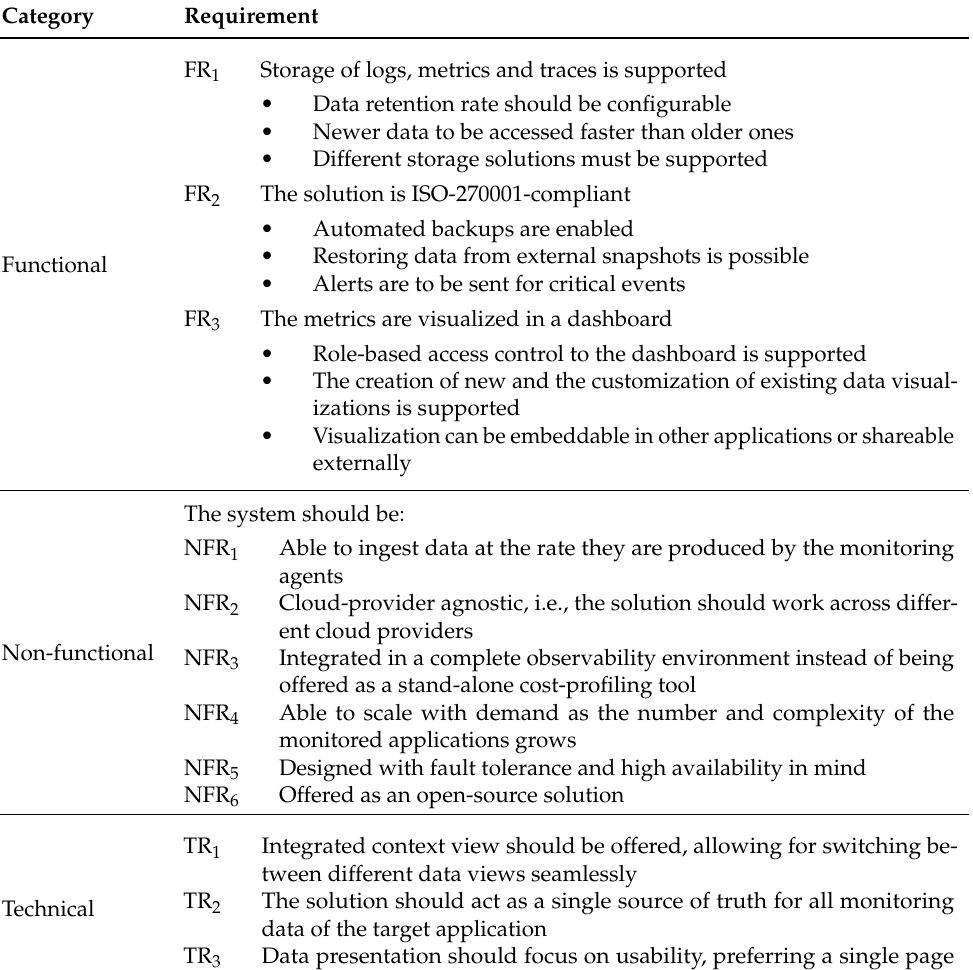
Table 2. Elicited requirements for the CPT solution from the case